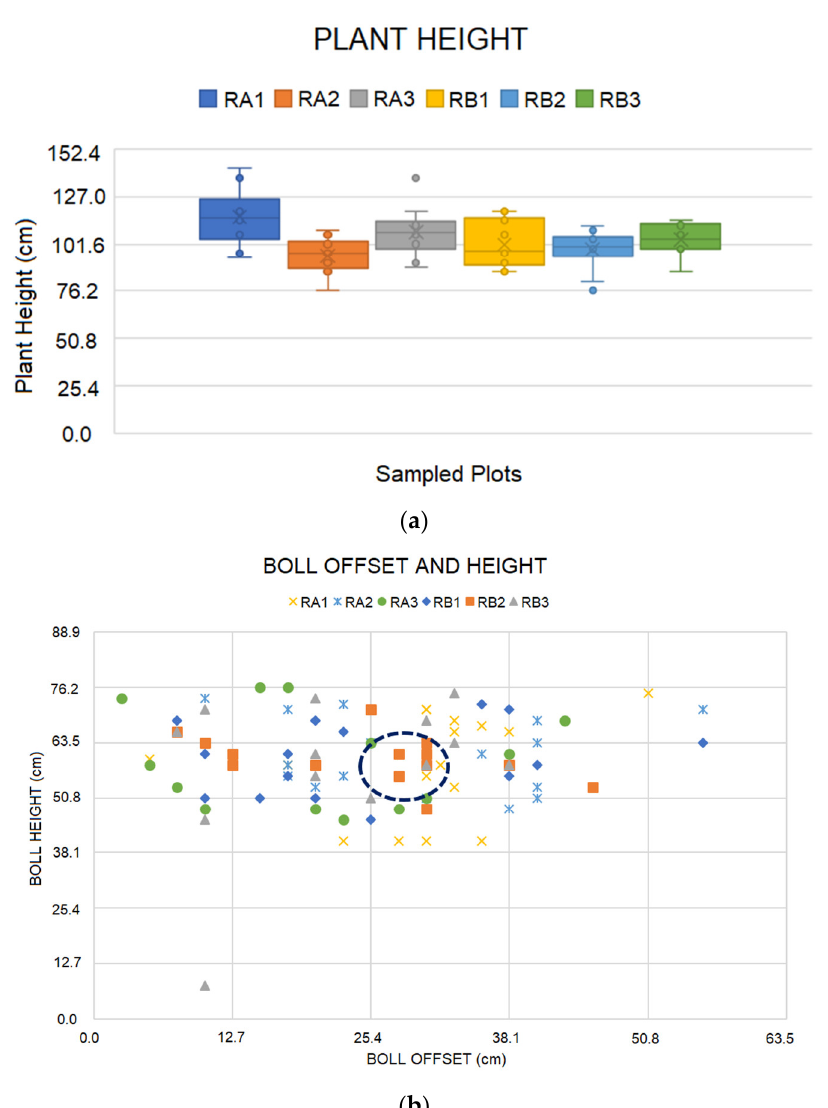
Figure 18. Results of the plant height ( a ), boll offset and boll height ( b ). Out of 135 bolls, approximately 20% of them are in the nozzle’s linear movement (cid:48) s direct path as it passes the plants. Hence, 27 bolls were expected to be harvested per row. However, based on the lab test conducted, the harvester (cid:48) s current configuration only allowed one lock per boll to be suctioned. Therefore, 27 locks were expected instead of 27 bolls. Results showed that Row A had 11 locks (40.7%), and Row B 20 locks (74.1%) harvested in total as shown in Figure 19. The average weight of each lock was 765 and 850 mg for Rows A and B, respectively. More locks per boll were harvested in Row B since in this row the plants have more fully opened/mature bolls compared to Row